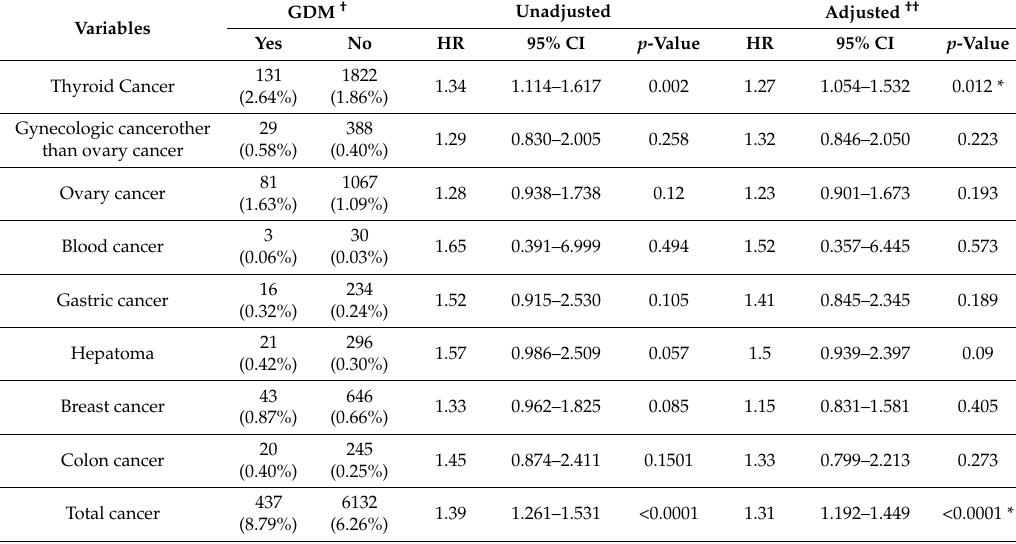
Table 2. The incidence of cancer by GDM (gestational diabetes mellitus) and the results of survival analysis for cancer by